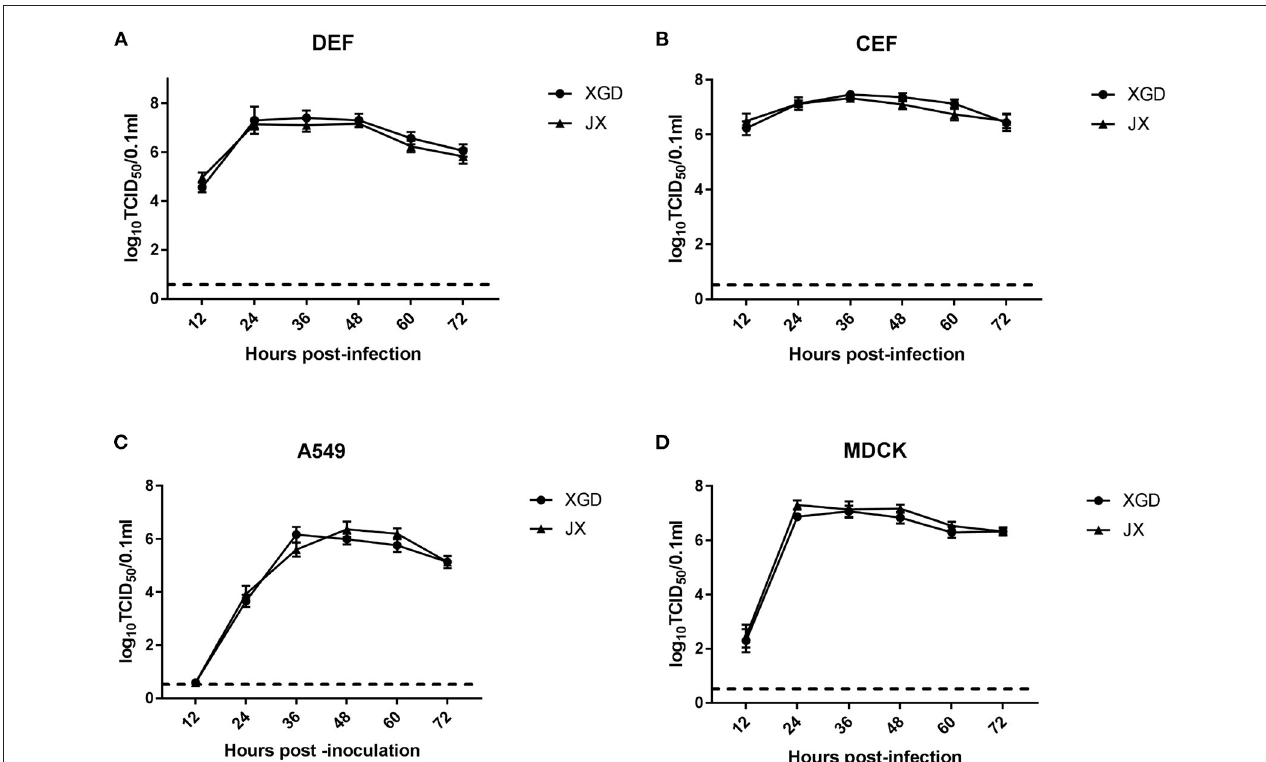
FIGURE 1 | Growth kinetics of the XGD and JX strains of H5N6 in vitro . Confluent (A) duck embryo fibroblasts (DEF), (B) chicken embryo fibroblasts (CEF), (C) lung carcinoma cells (A549), and (D) Madin–Darby canine kidney (MDCK) cells infected with XGD or JX at a multiplicity of infection (MOI) of 0.01. Samples were collected at 12, 24, 36, 48, 60, and 72h post-infection (hpi). Viral titers were determined using 50% tissue culture infective dose (TCID 50 ) assays in MDCK cells. The dotted line represents the limit of detection of viral titers. Data are presented as the mean ± standard deviation of triplicate experiments. Statistical significance was analyzed using an independent sample t